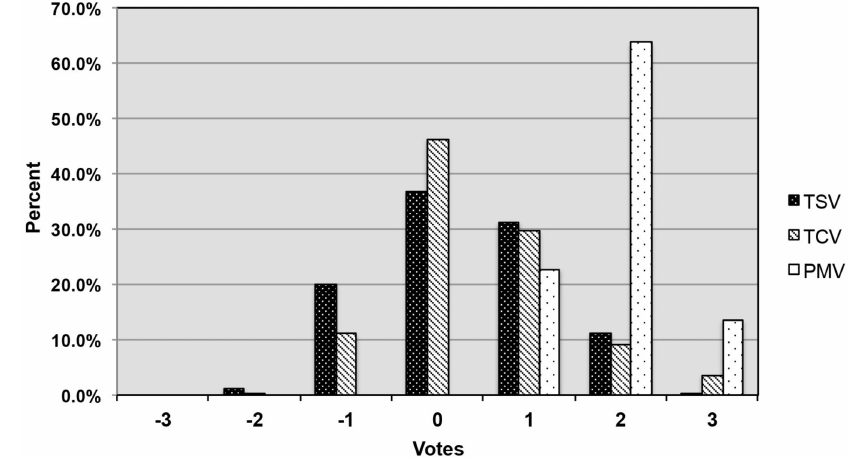
Figure 4. The percentage of PMV, TSV, and TCV.